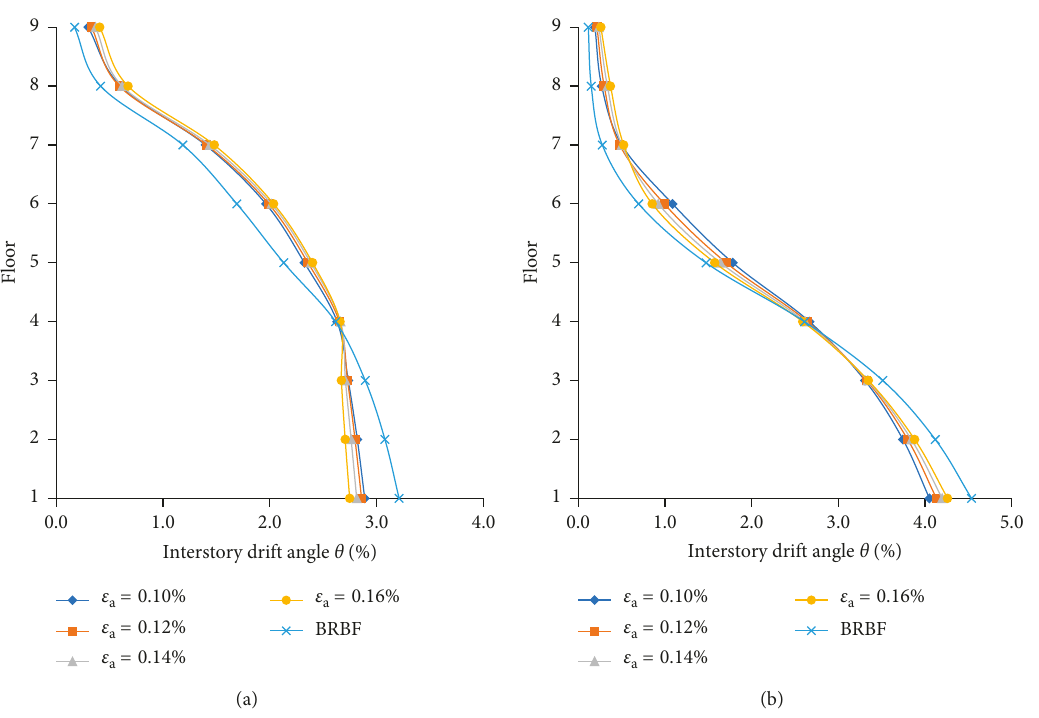
Figure 18: The effects of ε on the interstory drifts of 9-story SC-TOBFs: (a) LD-1 and (b) a